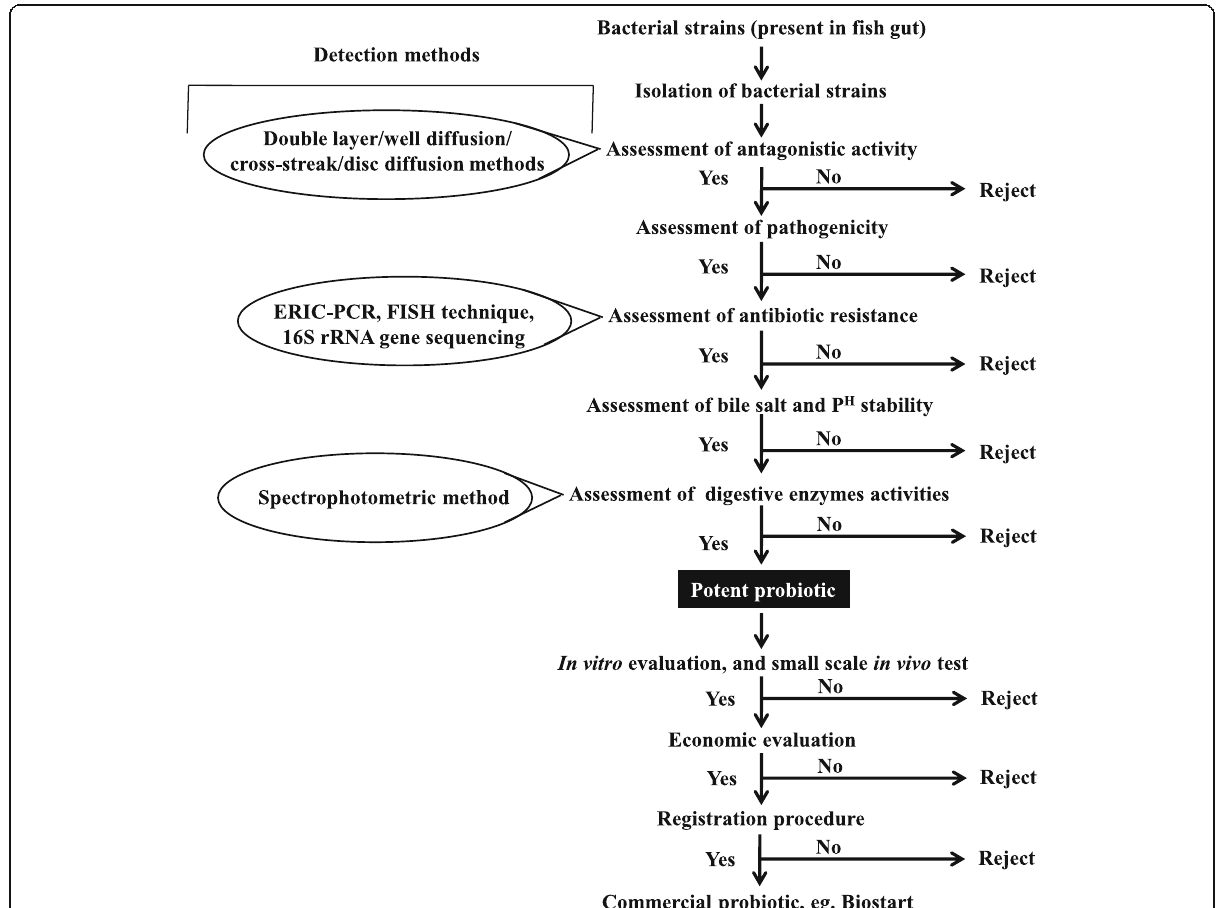
Fig. 1 Demonstrates the flow chart of different screening methods and selection criteria of probiotics in